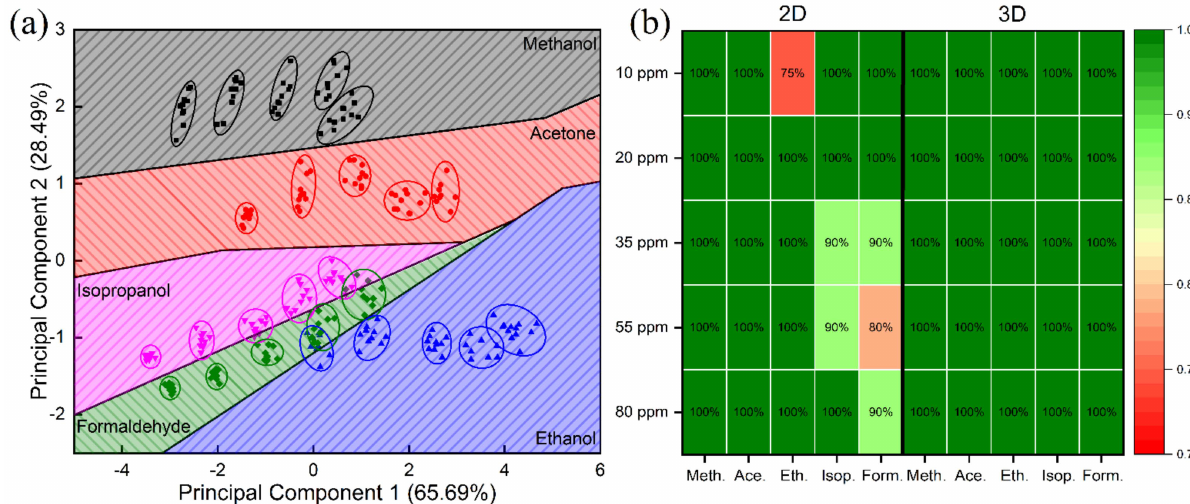
Figure 9. ( a ) Training result on the 2D-coodinate system with scores of PCA and support vectors of Linear-SVM towards target VOCs at different concentrations and ( b ) comparison of testing accuracy rate on qualitative and quantitative recognition under 2D- and 3D-coodinate